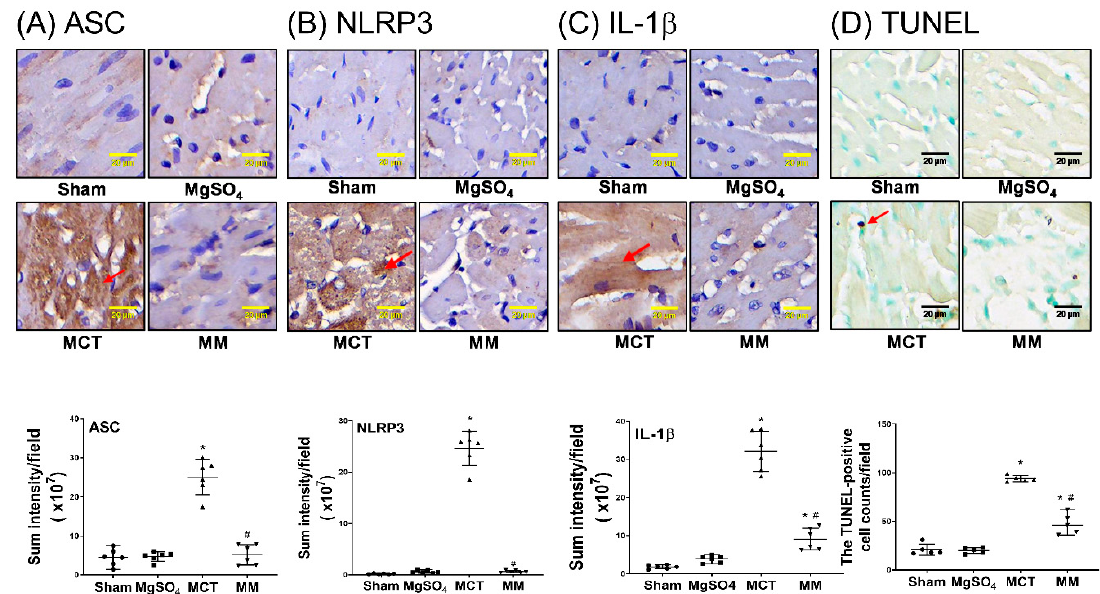
Figure 7. Magnesium sulfate (MgSO 4 ) mitigates the monocrotaline-induced upregulation of apoptosis, inflammasomes, and the inflammatory mediator in the right ventricular myocardium. Representative microscopic images obtained from the immunohistochemistry staining assay of the right ventricular myocardium (200 × ). Quantitative sum intensities of ( A ) apoptosis-associated speck-like protein containing a caspase recruitment domain (ASC, an adaptor protein for inflammasome receptors), ( B ) nod-like receptor protein 3 (NLRP3, the crucial element of inflammasomes), and ( C ) interleukin-1 β (IL-1 β ). Red arrows in ( A ), ( B ), and ( C ) indicate the representative images of ASC, NLPR3, and IL-1 β , respectively. ( D ) Representative microscopic images of DNA fragmentation in the right ventricular myocardium, as assayed by the terminal deoxynucleotidyl transferase dUTP nick end labeling (TUNEL) method (200 × ). Mean TUNEL-positive cell counts (per 0.25 mm 2 ) are presented. Red arrow indicates the representative images of TUNEL-positive nuclei. Sham: normal saline group. MgOS 4 : MgSO 4 (100 mg / kg / day) group. MCT: monocrotaline (60 mg / kg) group. MM: monocrotaline (60 mg / kg) plus MgSO 4 (100 mg / kg / day) group. Data are expressed as median (range). Data of ASC, NLRP3, IL-1 β , and TUNEL were obtained from six, six, six, and five rats from each group, respectively. * p < 0.05 versus the sham group. # p < 0.05 versus the MCT group.